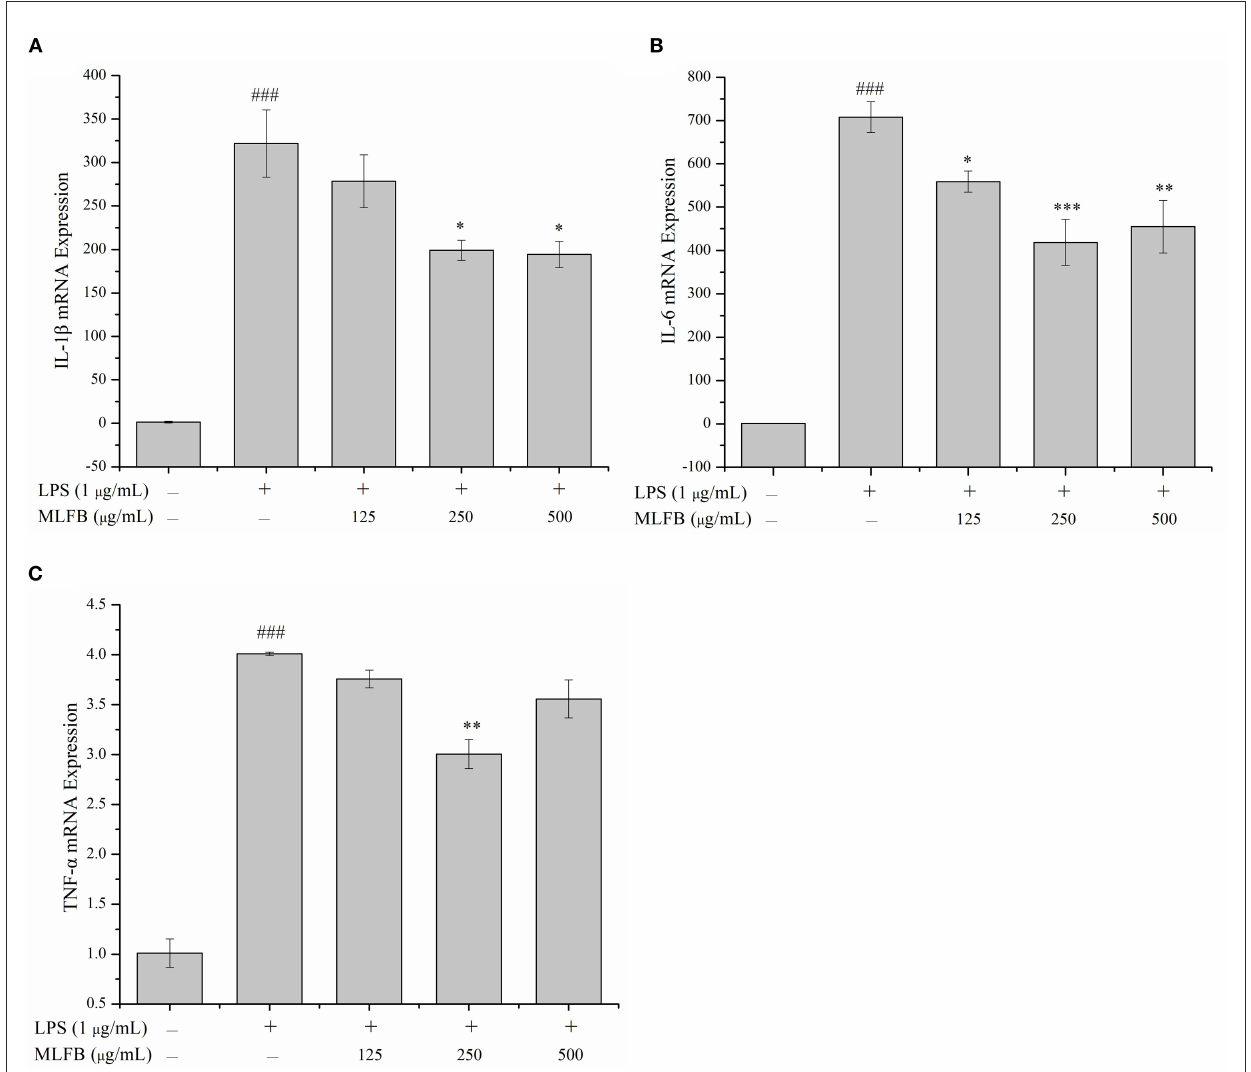
FIGURE3 Effects of MLFB on the mRNA expressions of IL-1 β (A) , IL-6 (B) , TNF- α (C) in LPS-induced RAW 264.7 cells. # Means statistical difference compared with blank control group ( ### P < 0.001). *Means statistical difference compared with LPS-induced inflammatory model group (* P < 0.05, ** P < 0.01, *** P <